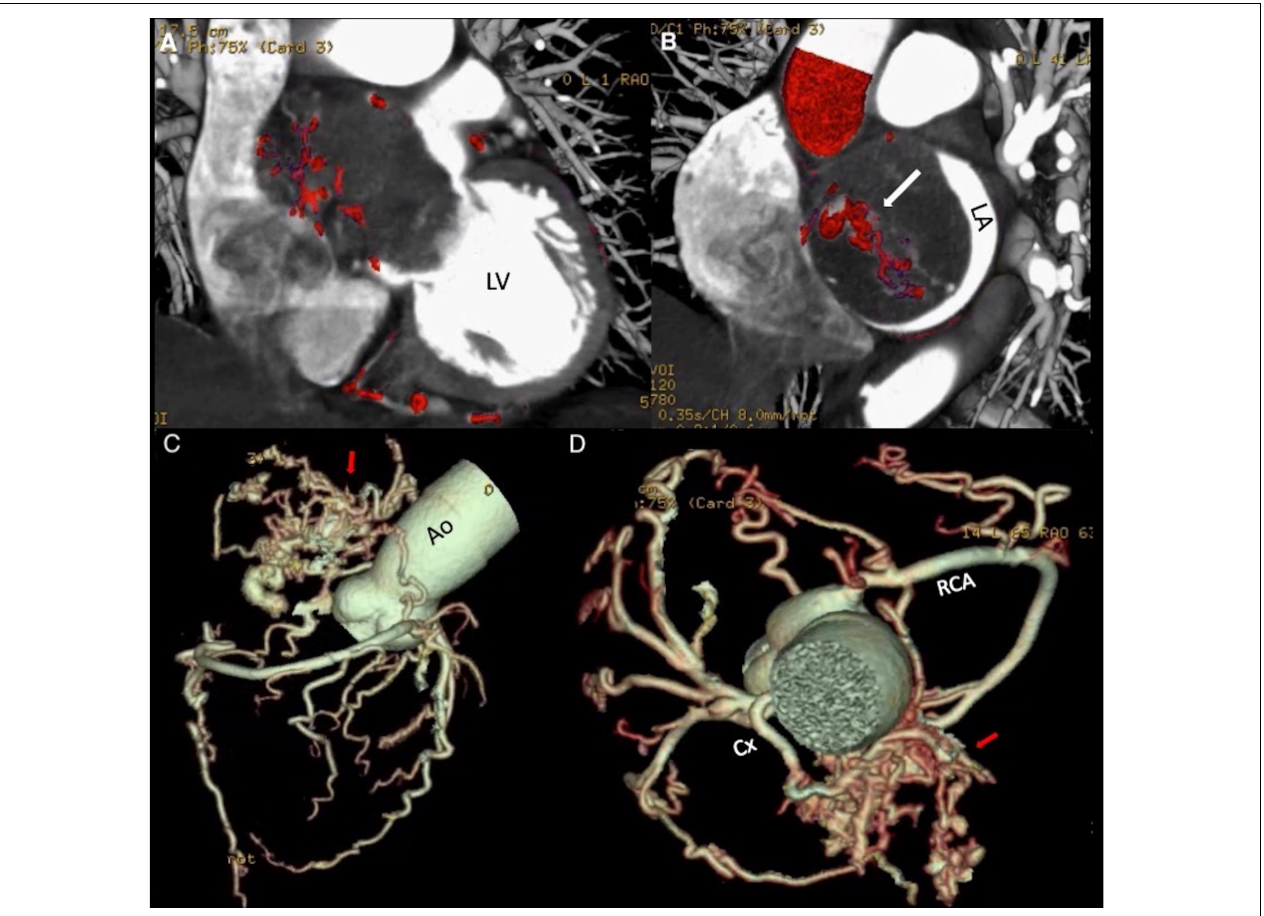
FIGURE 3 | (A,B) Coronary Computed Tomography Angiography. Hypodense mass located in the left atrium attached to the interatrial septum, with a dense network of blood vessels within. The intra- atrial mass protrudes through the mitral valve into the left ventricle during diastole, causing impairment of the atrial emptying and mitral valve closure. (C,D) Coronary Computed Tomography Angiography reconstruction. Complex blood vessel network (arrows) anastomosed to branches of the circumflex artery and the right coronary artery ( Supplementary Video 3 ). Ao, aorta; Cx, circumflex artery; LA, left atrium; LV, left ventricle; RCA, right coronary